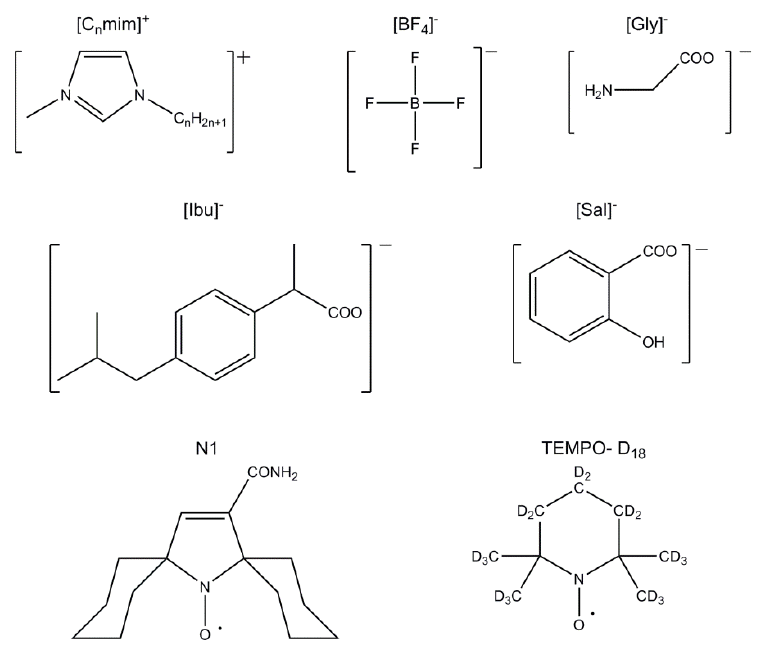
Figure 1. ( a ) The two-pulse electron spin-echo detected spectrum of the nitroxide radical (top). The T 2 decay is measured by an incremental delay, τ , in the π/2 - τ - π - τ - echo sequence at two spectral positions, I and II (bottom). Corresponding T 2 times are obtained by a monoexponential analysis. ( b ) Schematic representation of the temperature dependence of the motional parameter, L, for the nitroxide radical in ILs and other organic glasses, showing a low-temperature region with negligible librations ( T < 60 K) and then their onset, the linear region of effective librations ( T ~100–150 K), the anomaly region ( T ~150–200 K), and the transition into a liquid state with a steep increase in molecular motions at T g . This L ( T ) dependence was obtained for the spin probe N1 (Scheme 1) that was dissolved in the ionic liquid, [BuPy][BF 4 ] (more details in [30]).